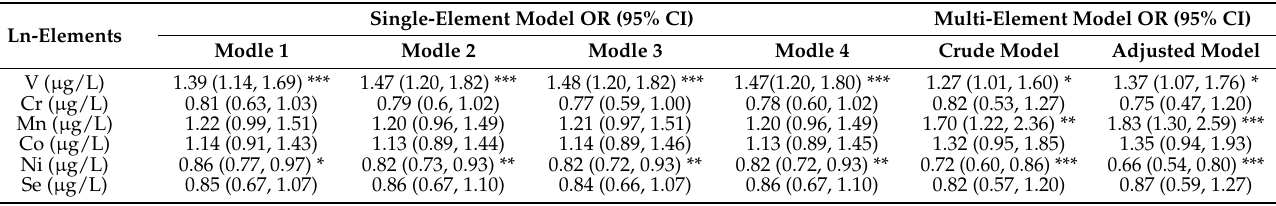
Table 3. Associations between plasma trace element exposure and GDM risk.